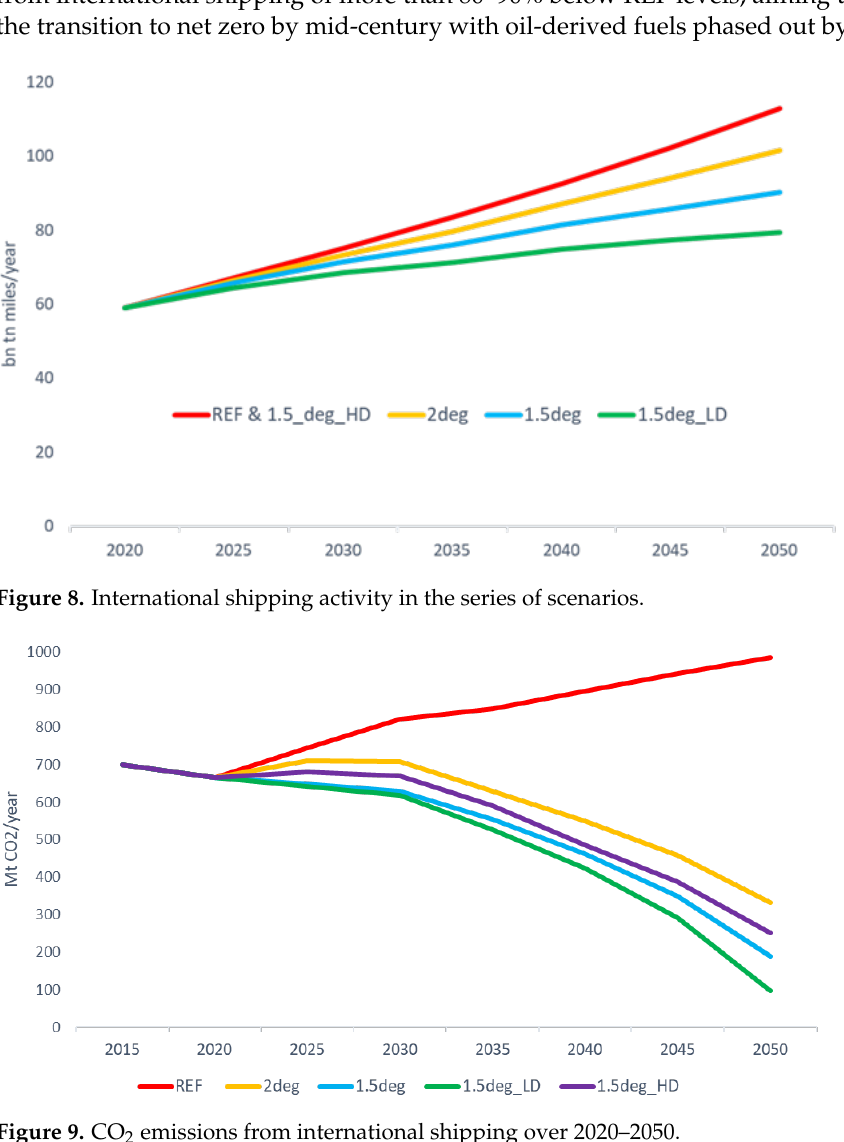
Figure 9. CO 2 emissions from international shipping over 2020 – 2050.